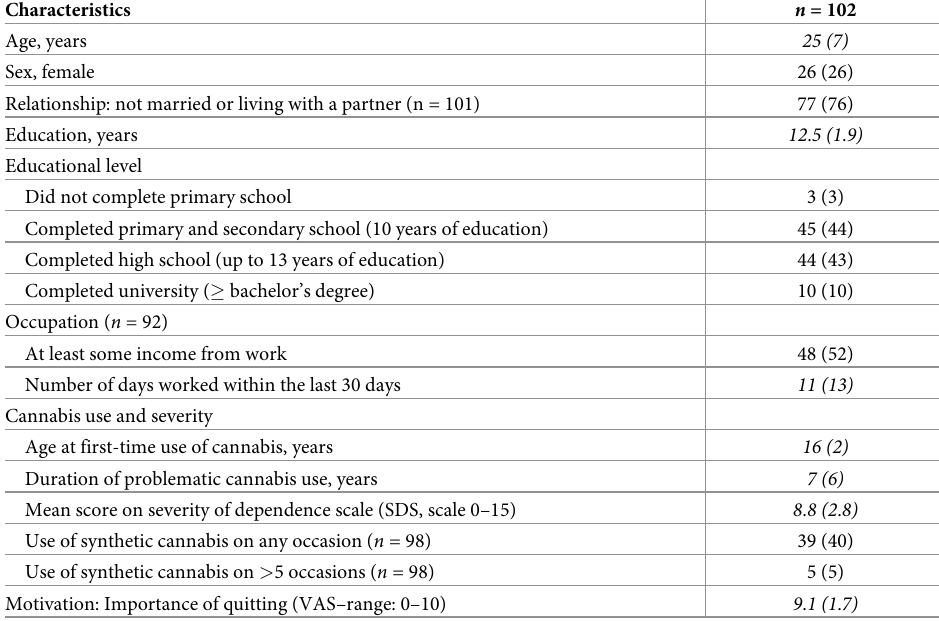
Table 2. Sociodemographic characteristics of study respondents.